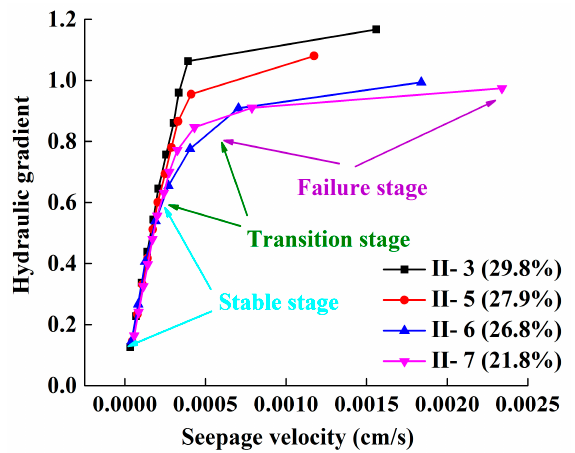
Figure 11. Hydraulic gradient–seepage velocity curves under different clay contents.